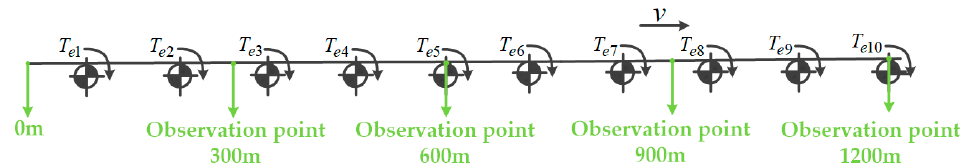
Figure 8. Distribution of observation points on the distributed permanent magnet direct-drive belt conveyor.